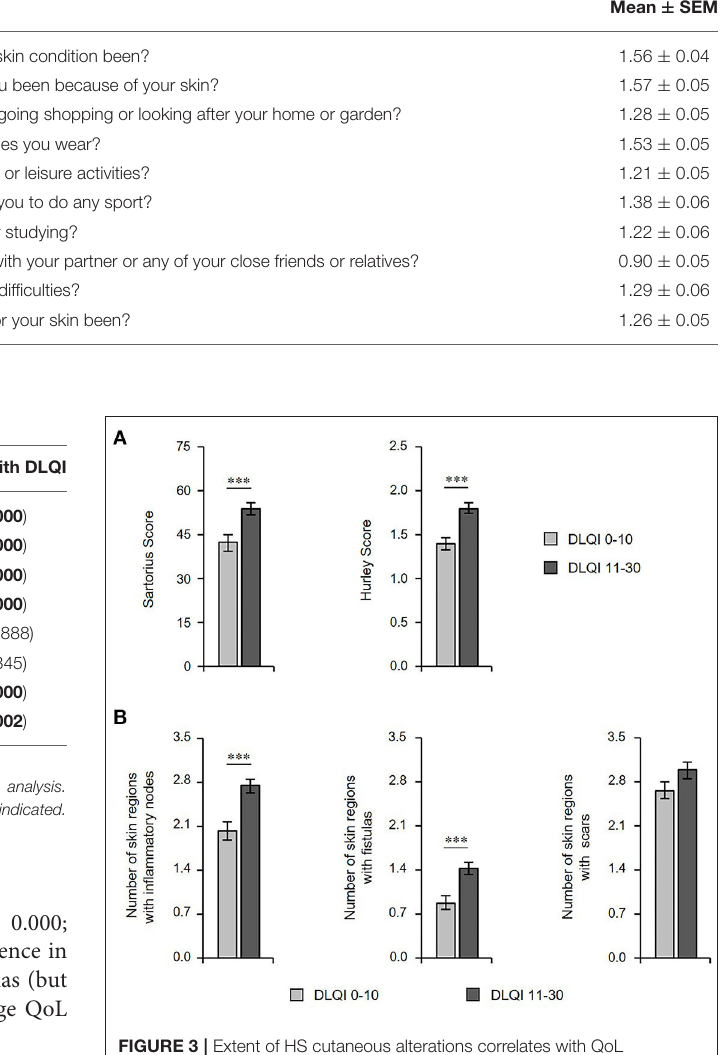
FIGURE 3 | Extent of HS cutaneous alterations correlates with QoL impairment. (A) The disease severity (Sartorius score, n = 418; Hurley score, n = 411), and (B) number of skin regions with inflammatory nodes, fistulas, and scars ( n = 415) in patients with HS with small/moderate (DLQI ≤ 10) and very/extremely large (DLQI > 10) QoL impairment are indicated as mean ± SEM. The significance of differences was assessed using the Mann-Whitney U test (two-tailed; *** P ≤ 0.001). DLQI, Dermatology Life Quality